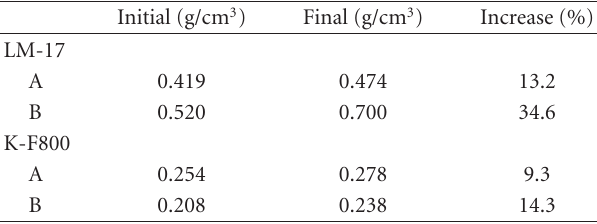
Table 1: Bulk density testing